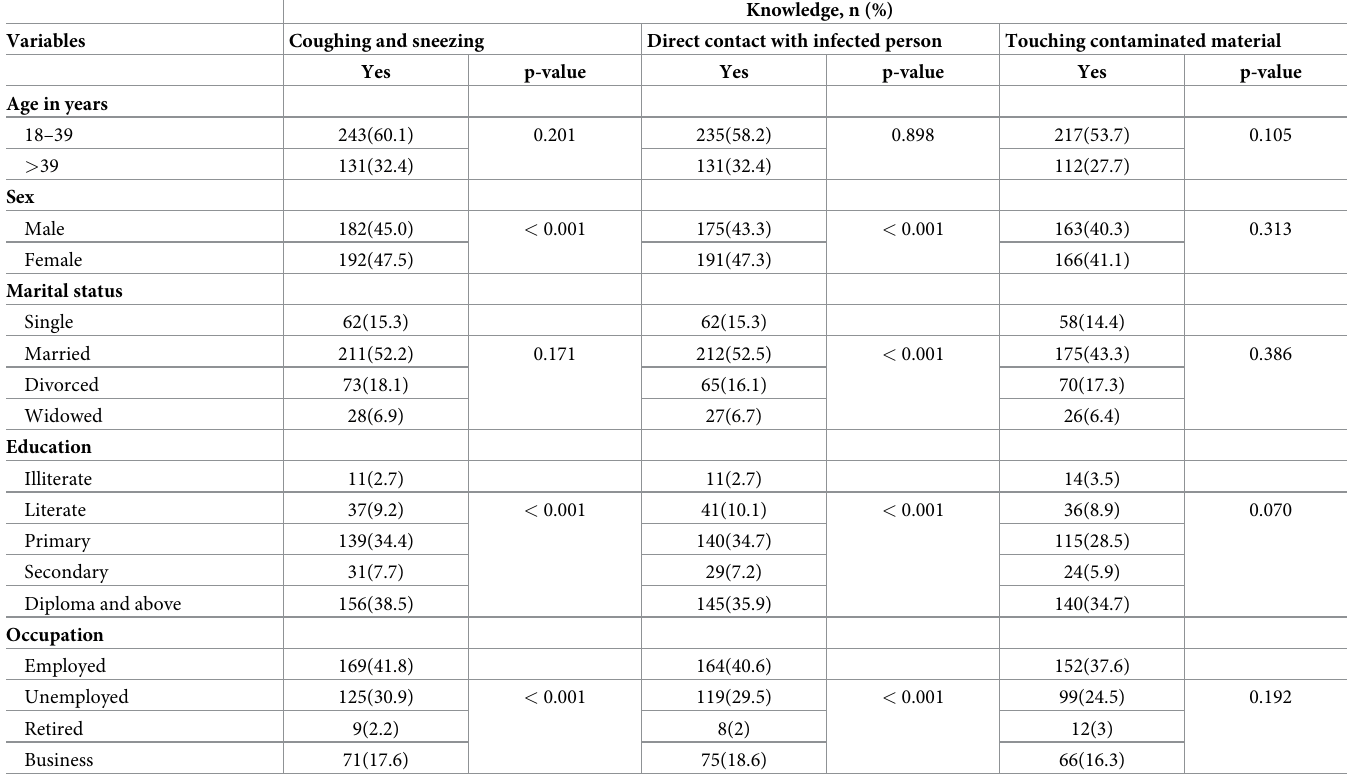
Table 3. Bivariate analysis to determine the association of knowledge with socio- demographic characteristics of the respondents towards COVID-19 (n =